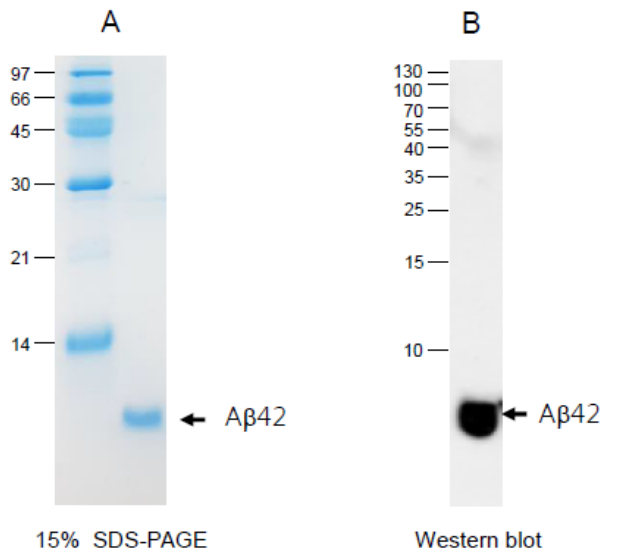
Figure 1. Electrophoretic patterns of purified A β 42 ( A ) and identification by Western blot ( B ). In the non-denaturing state, lipid-free A β showed an aggregated band pattern on the top of the loading position, as indicated by the red arrowhead (Figure 2A). In con- trast, apoA-I showed a typical broadband pattern from 65 to 73 Å. In the lipid-bound state, the A β was condensed, and the aggregated band pattern was observed on the top of the loading position, whereas apoA-I in a lipid-bound state showed a major single band at 97 Å, as a black arrowhead. With an increasing amount of A β in the rHDL, the particle size gradually decreased up to 93 Å with a weaker smear intensity. This result indicates that A β interferes with the normal binding of apoA-I with phospholipid to form rHDL, although the solubility of A β was enhanced by the rHDL formation. Denaturing electrophoresis (18% SDS-PAGE) also showed that a more aggregated band appeared with increasing A β content in the rHDL (Figure 2B). A β in the lipid-bound state showed an aggregated band with lipid species and multimerization, as indicated in the red ar- rowhead. These results suggest that the addition of A β to the rHDL containing apoA-I severely impaired the stabilization of apoA-I in the rHDL